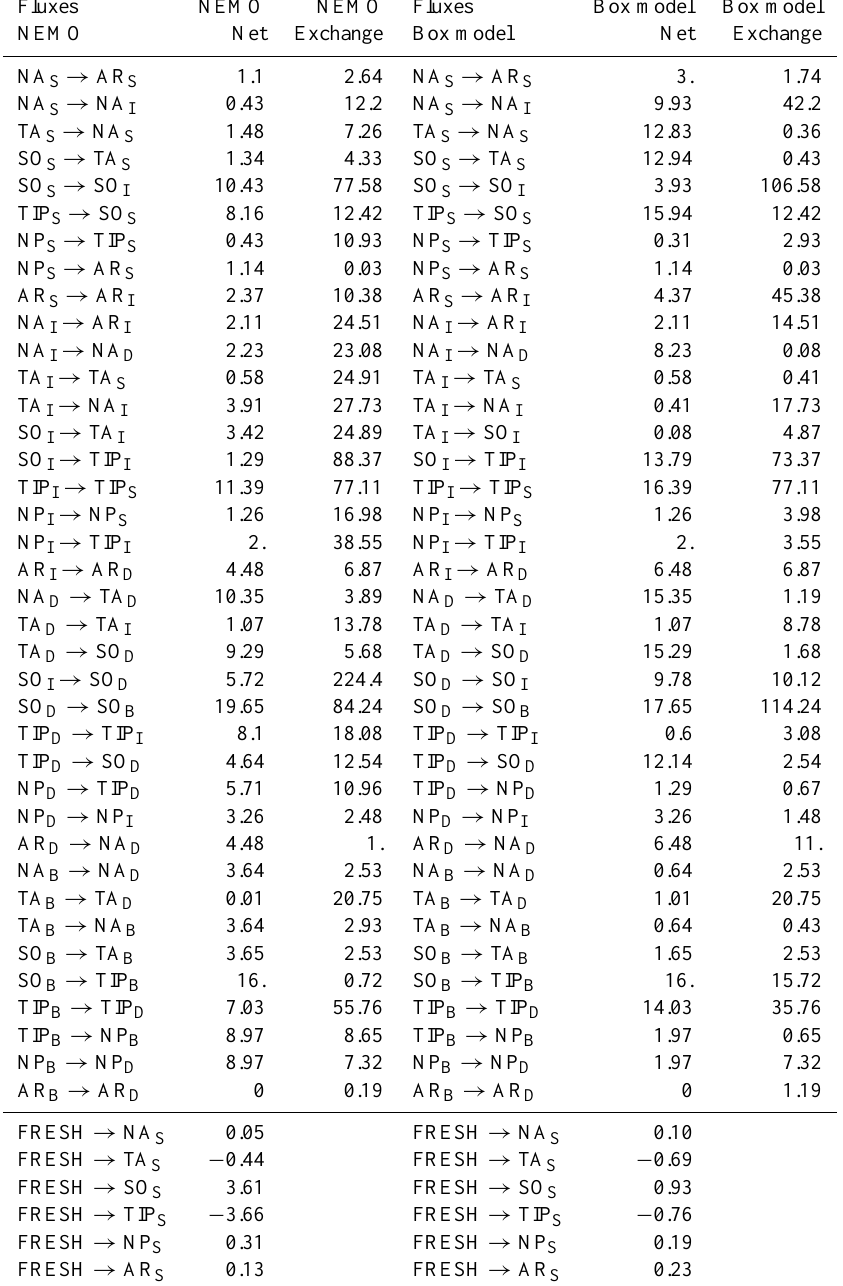
Table A3. Water fluxes (in Sv) derived from the NEMO model run and fluxes applied in the box model to reproduce observed tracer distributions (Tables A1 and